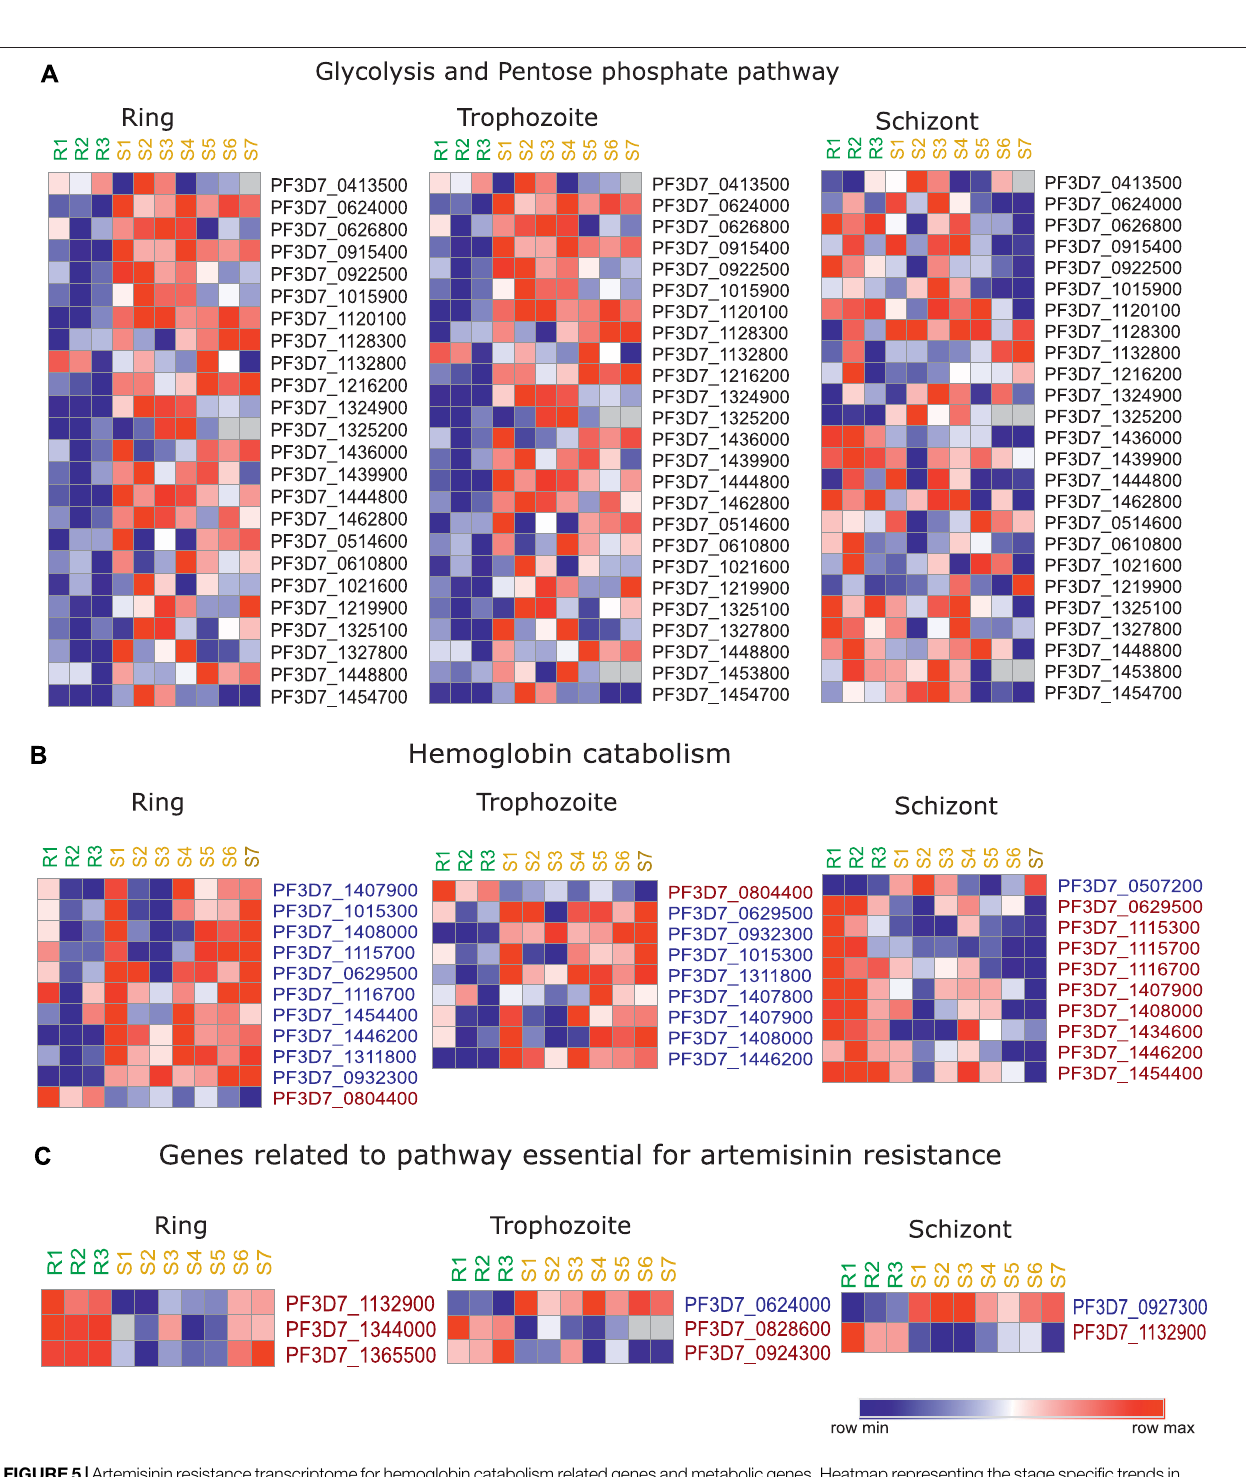
Frontiers in Genetics |